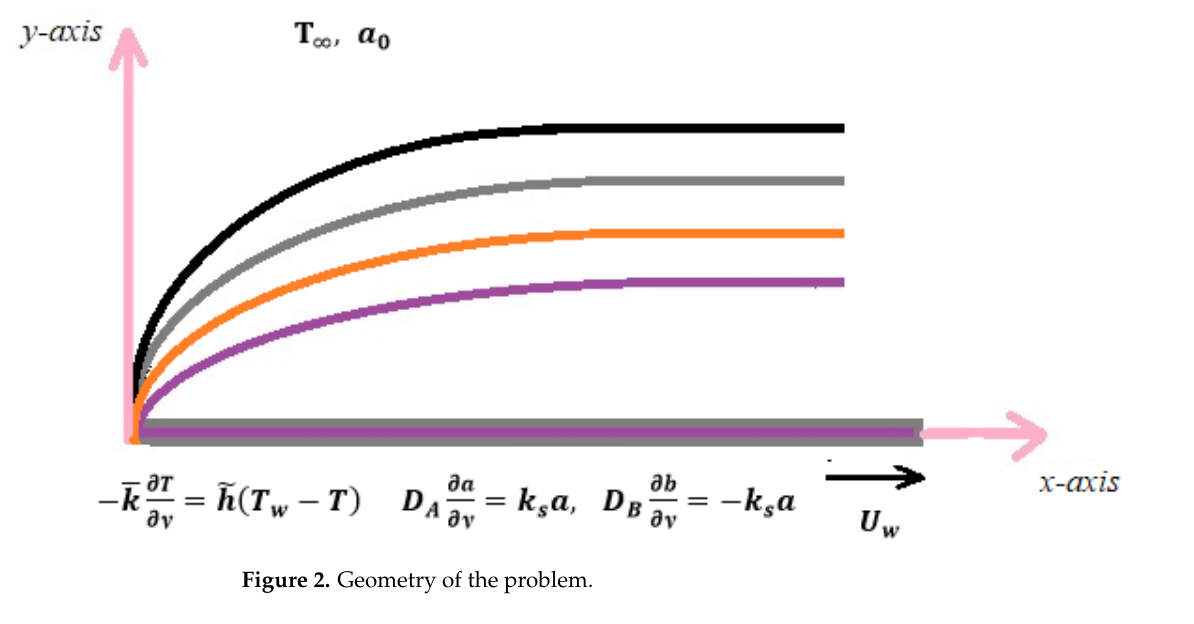
Figure 2. Geometry of the problem.